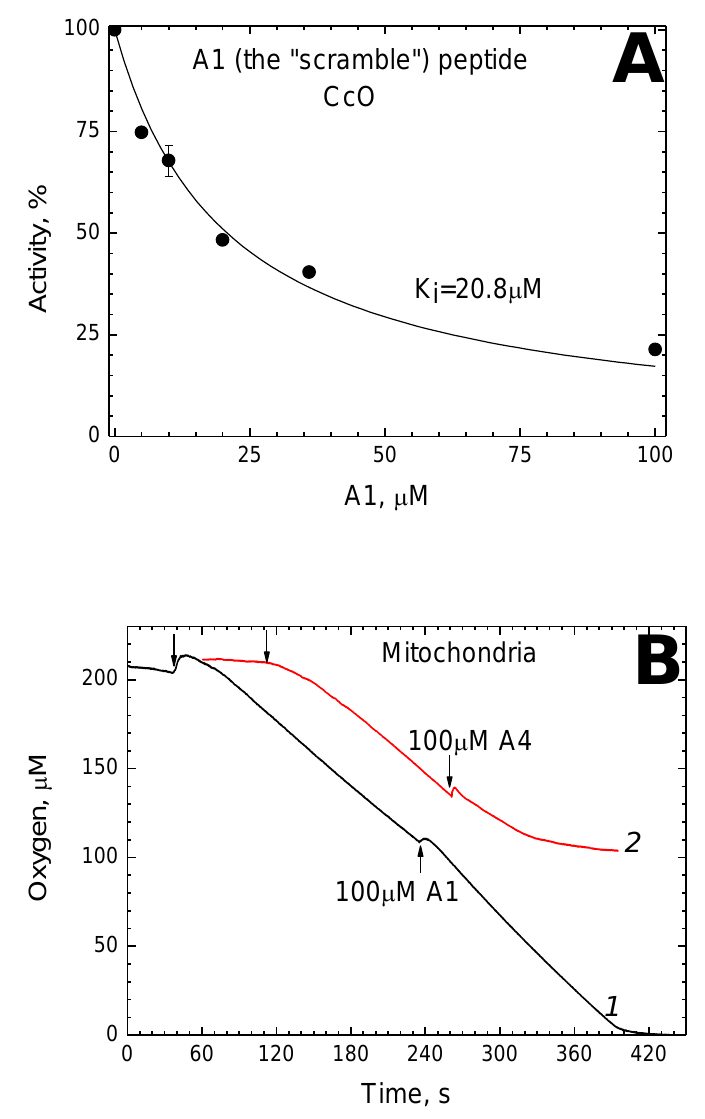
Figure 5. Susceptibility of the CcO activity to A1. ( A ) The dependence of the oxidase reaction rate on the A1 concentration in solution. All conditions are as in Figure 1. The approximating hyperbolic function (1) is drawn. ( B ) Effect of peptides A1 and A4 on mitochondrial respiration. See Figure 4 for the conditions. The addition of respiratory substrate is shown by the arrows. Additions of the peptides in the course of respiration are indicated.